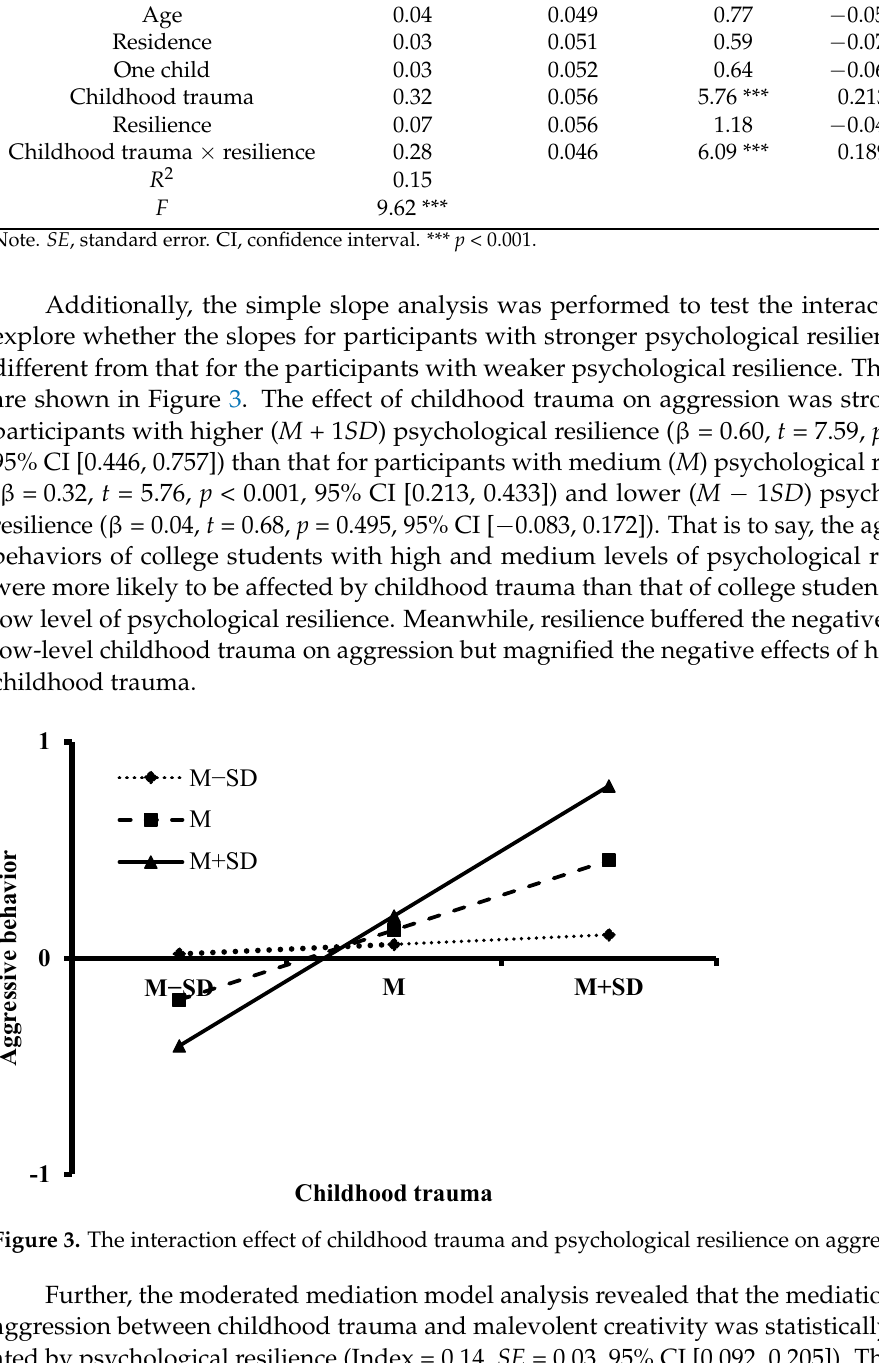
Table 4. The moderated indirect effect.